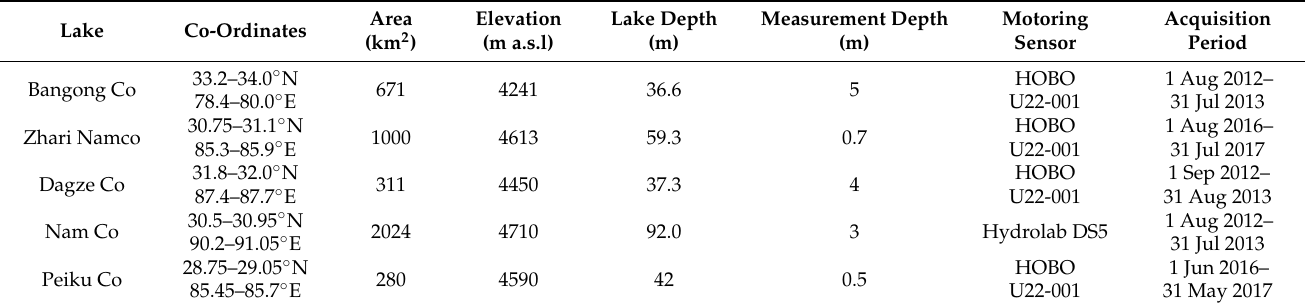
Table 1. Geographical information and measurement information on the buoy stations for the five lakes. The lake depths are at the buoy